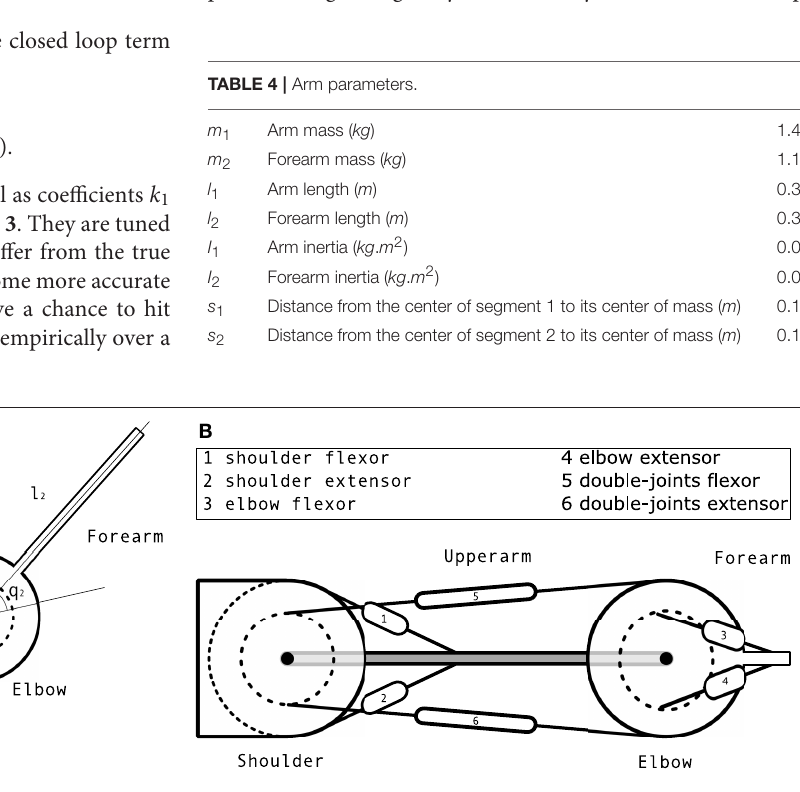
FIGURE 7 | Arm model. (A) Schematic view of the arm mechanics. (B) Schematic view of the muscular actuation of the arm, where each number represents a muscle whose name is in the box.